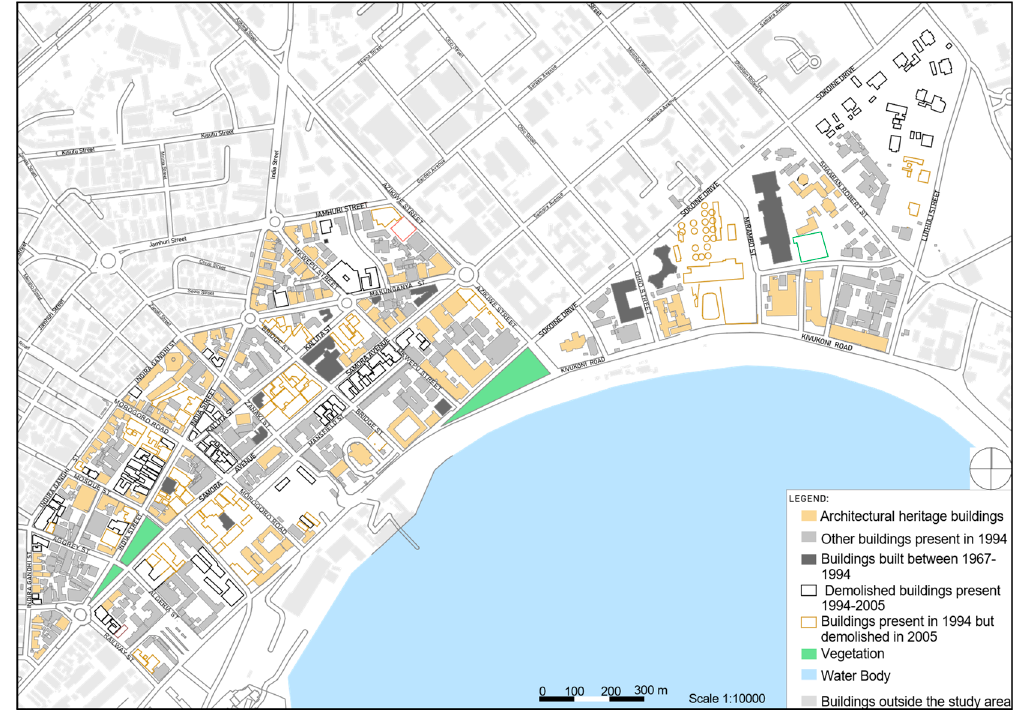
Figure 4. Demolitions and new buildings between 1967 and 1994 (Source: Author, 2020. Modified from a satellite image of 1967 and an aerial photograph of 1994.